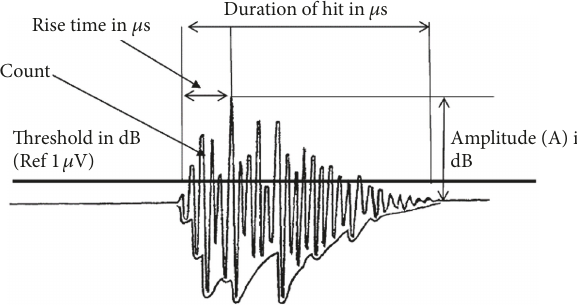
Figure 4: Typical AE features extracted from the recorded signal (hit) [12].